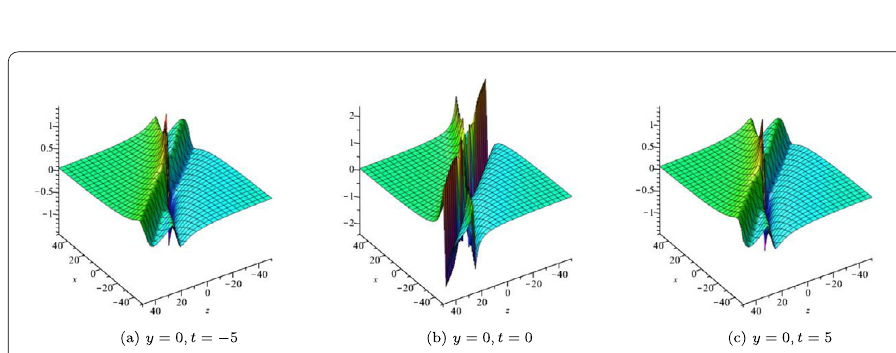
Figure 10 Two-line rogue waves for Eq. (1.2) in the ( x , z ) plane with the parameters defined in Eq.